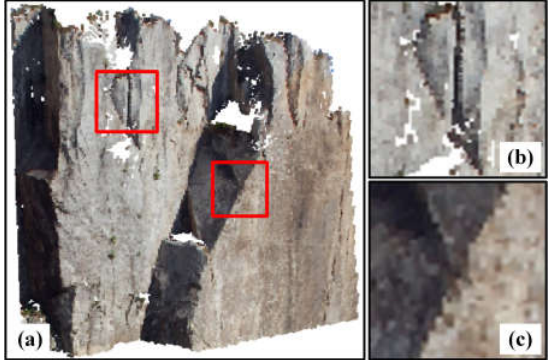
Figure 3. 3D point cloud of a rock mass. ( a ) Example case; ( b ) crack with a nonsignificant curvature change; ( c ) discontinuity trace with an obvious curvature change.